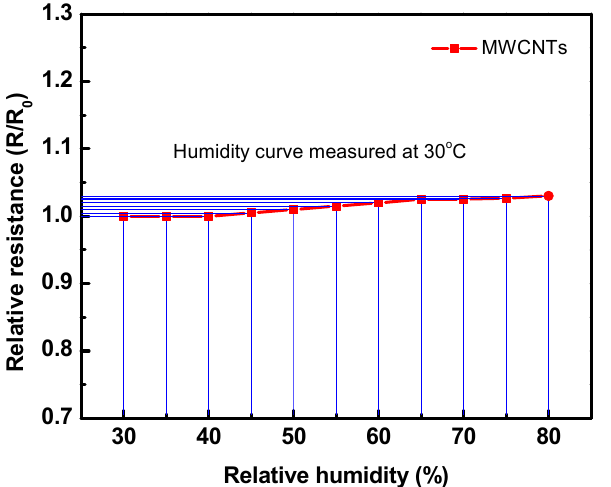
Figure 13. Relative resistance of the sensor at various humidity conditions for the fabricated sensor measured at 30 °C.